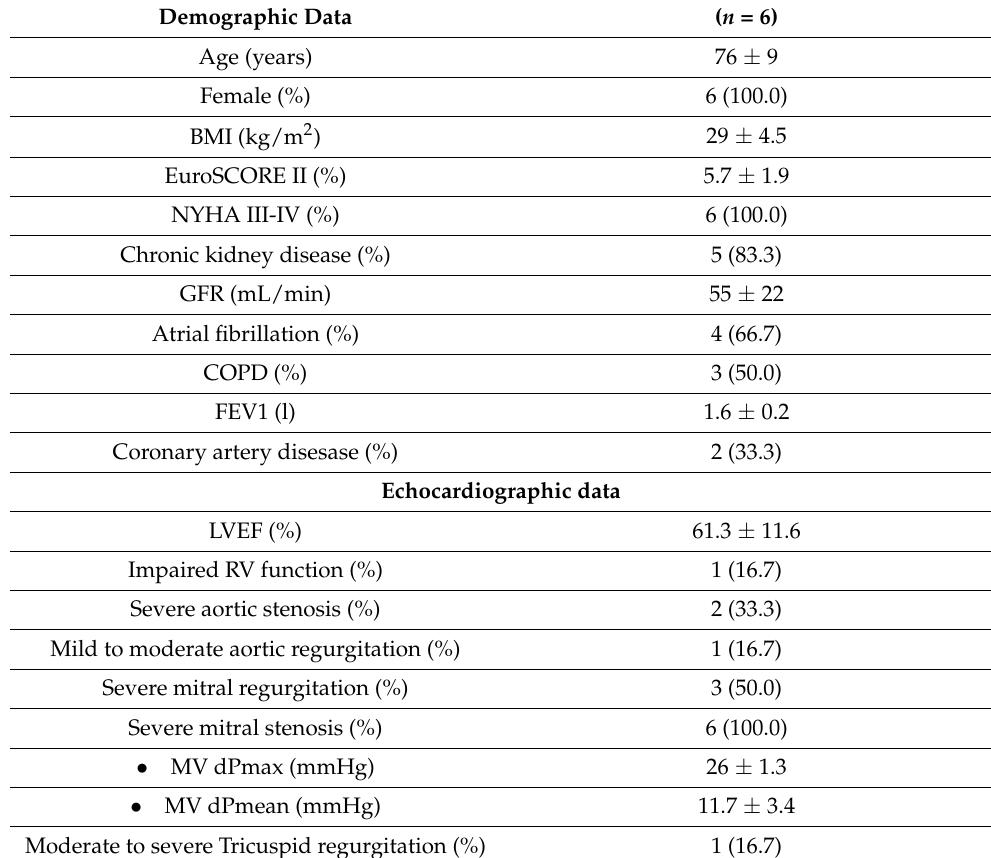
Table 1. Demographic and Echocardiographic